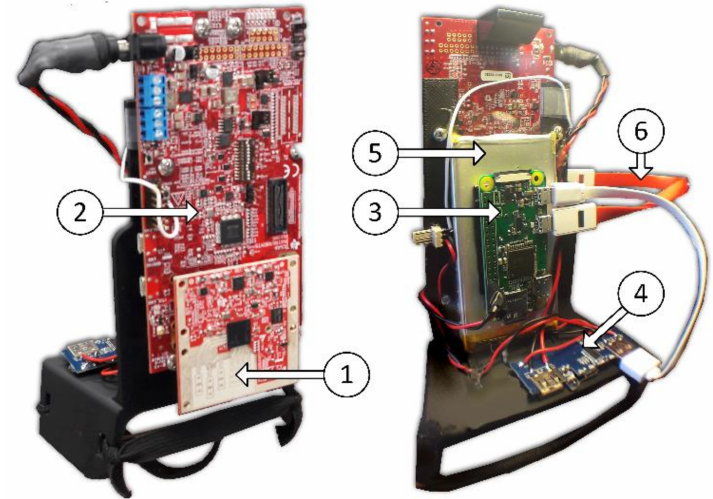
Figure 6. Smart-shoe instrumented foot-mount assembly. (1) IWR6843ASK Antennas and board, (2) MMWAVEICBOOST board, (3) Raspberry Pi Zero W+, (4) Power management board, (5) LiPo Battery and (6) USB Data cable. The mount was 3D printed and all the PCB boards and battery were fixed to it. The setup was mounted to the shoe using elastic bands.